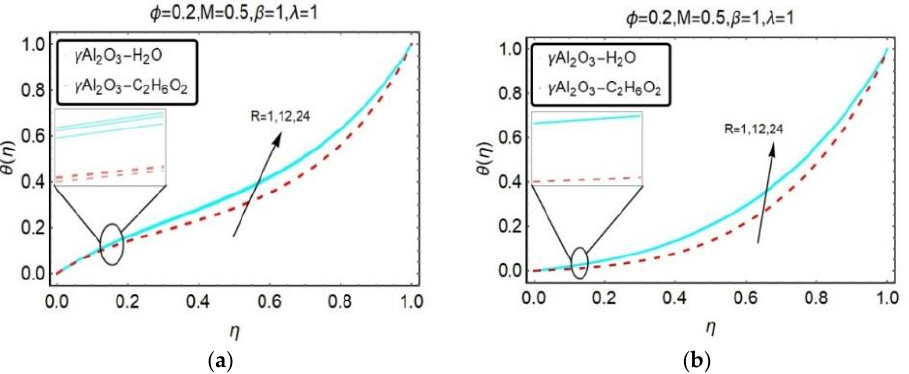
Figure 16. Influence of 𝑅 on 𝜃(𝜂) for ( a ) 𝑆 > 0 and ( b ) 𝑆 < 0 .